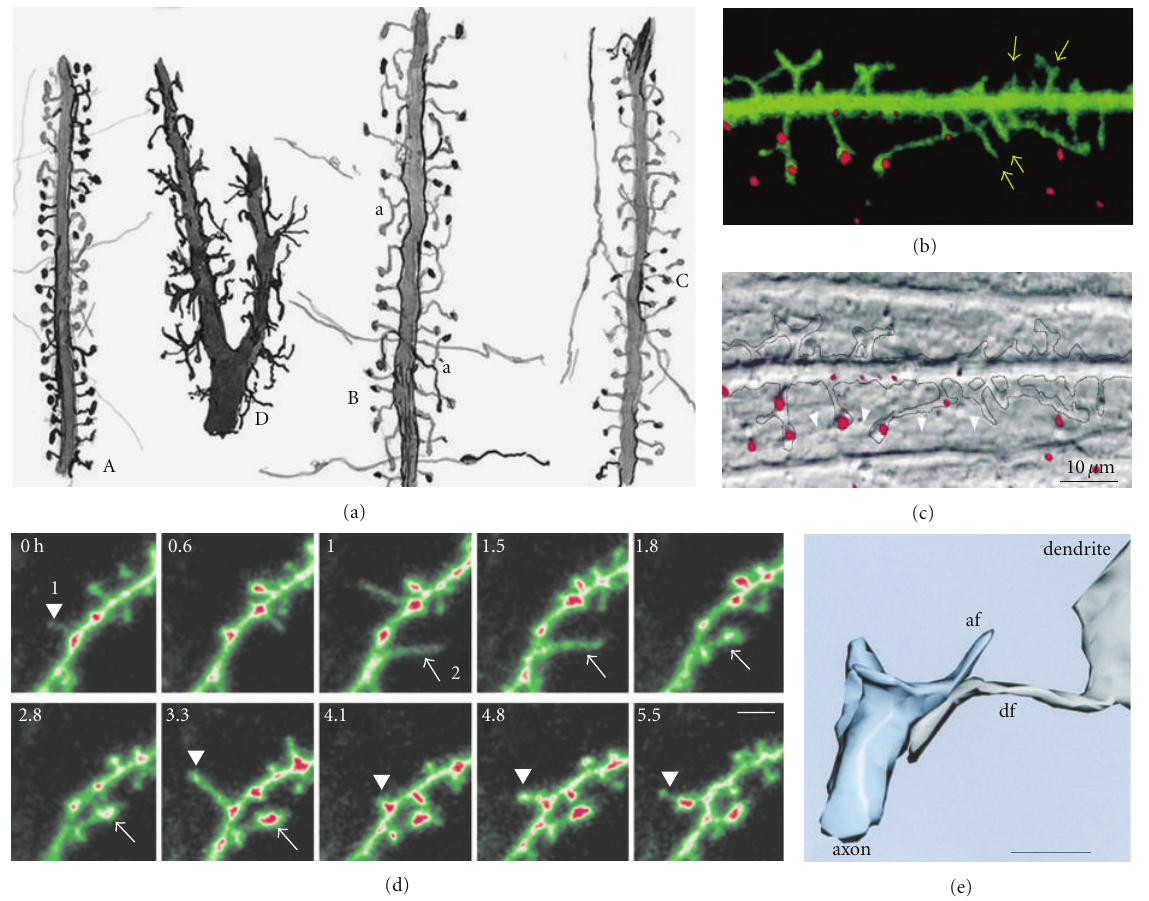
Figure 6: (a) Illustrates a Cajal scientific drawing [17]. The English translation of the original legend of this drawing is in the endnote 3 of the text. We would like to remark filopodia in (D) motor cell, spinal cord, one-month-old cat, and the presence of dendritic appendages with mixed characteristics between filopodia and spines (protospines) in (B) visual cortex, two-month-old child. (b) Synapses at sites of contact between filopodium-like dendritic protrusions and axons [18]. Dendritic appendages of great motility (arrows), a FAST DiO-labeled dendrite (green) and FM4–64-labeled presynaptic buttons (red) in an in vitro preparation of 14 days. (c) Di ff erential interference contrast image of the same field. The parallel axon (arrowheads) 5–7mm below the labeled dendrite (dashed outline) has formed synapses (red) with several dendritic protrusions. (d) New PSD95 clusters emerge in dendritic filopodia that transform into protospines and spines [19]. In a confocal time-lapse sequence of a neuron expressing PSD95-GFP, transient filopodia, devoid of clusters, repeatedly protrude and withdraw at a site (1, 0h) overlying a shaft cluster. Later, a new filopodium emerges (arrowhead, 3.3h) and transforms into a cluster-containing protospine (arrowhead, 5.5 h). At another site (2, 1h), a filopodium extends, persists and stabilizes coincident with de novo formation of a cluster (arrow, 1.8–3.3 h), scale bar, 3 μ m. (e) synaptic interaction between axonal (af) and dendritic filopodia (df), postnatal day 4, Hippocampus, CA1, three-dimensional reconstruction of electron microscopy images, scale bar 1 μ m [20].